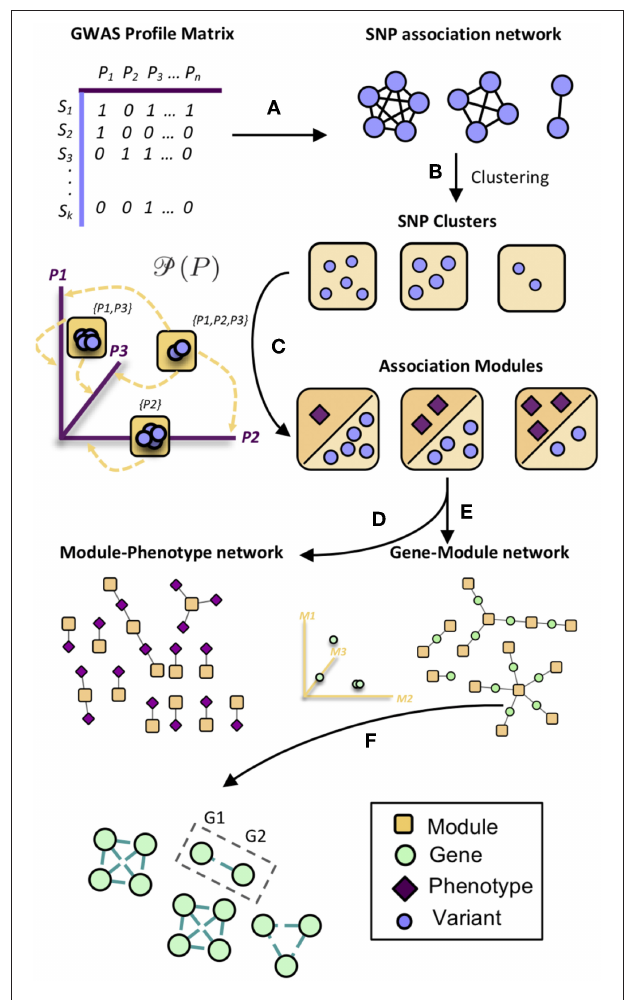
FIGURE 2 | Overview of MPA decomposition and signature clustering. (A) The GWAS profile matrix M representing SNP-phenotype associations was constructed, and the Proportional Similarity between all pairs of SNPs (rows of M ) was calculated. (B) Clustering of the SNP association similarity network results in clusters of SNPs with the same phenotype associations. (C) Association modules are constructed as elements of the powerset of phenotypes observed in the SNP clusters. Association modules can thus be seen as non-overlapping sets of SNPs, or overlapping sets of phenotypes. These modules form the axes of powerset space. (D) The module-phenotype network associates the phenotypes present in each element of the powerset observed in the SNP association clusters. (E) The gene-module network is constructed by mapping genes to association modules if the module contains a SNP that resides within that gene. (F) Signature clustering is performed in GM (powerset) space, grouping genes with the same module associations. Clustering genes in powerset space results in groups of genes with the same pattern of MPA signatures with the same set of phenotypes. For example, a signature cluster could involve G1 and G2 containing SNPs associating with both phenotypes P1 and P2, as well as a SNP associating with only